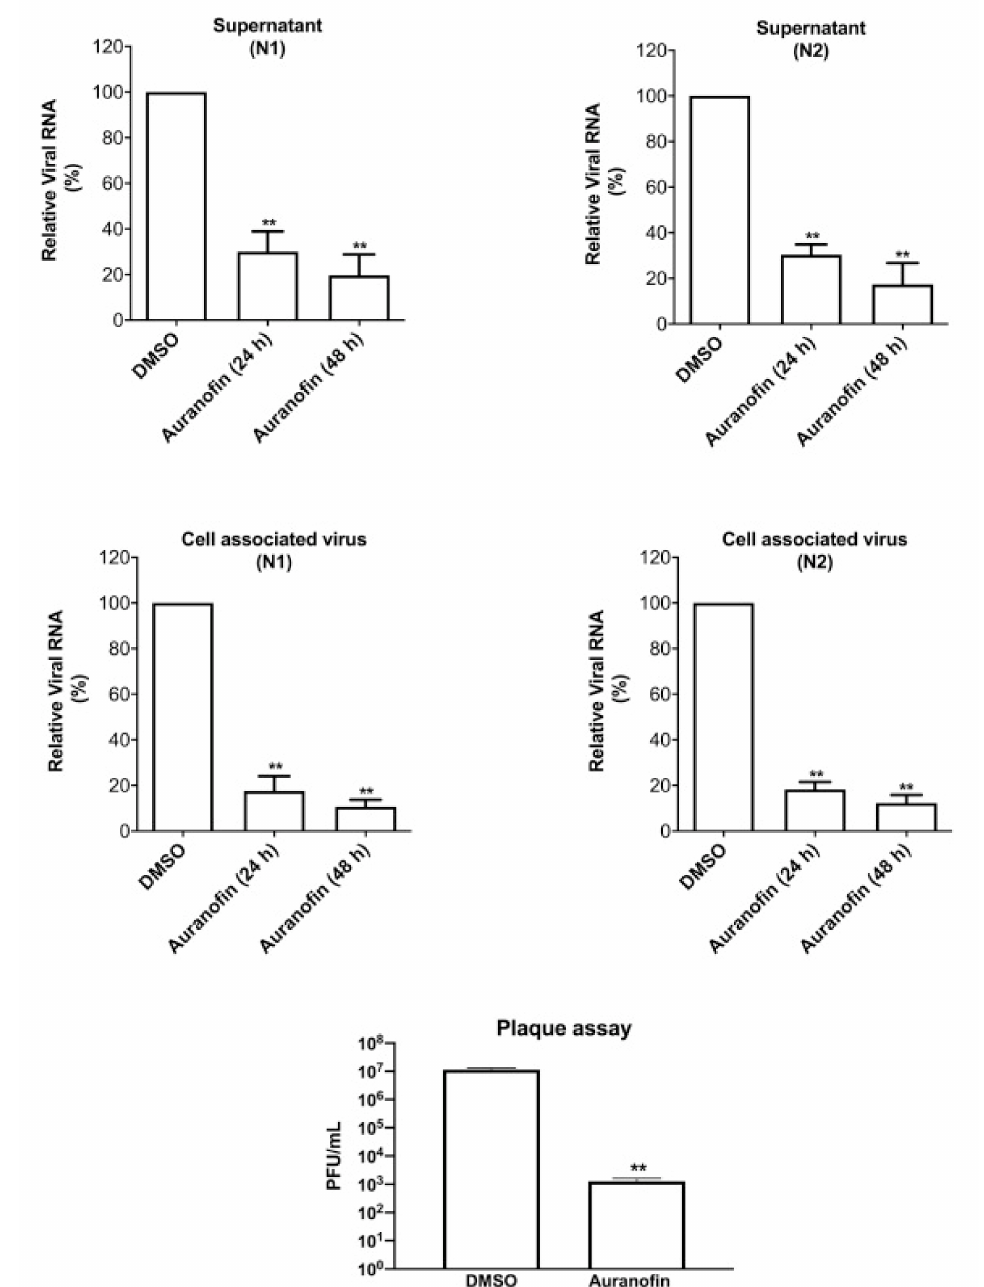
Figure 7. Auranofin inhibits SARS-CoV-2 proliferation in living organisms. Huh7 infection is associated with SARS-CoV-2 for 2 h at a multitude of infected (MOI) from one before ever being incubated with 4 M auranofin or 0.1 DMSO. Cell lysates and culturing filtrates were obtained 24 and 48 h after transmission, and viral RNA rates were measured using RT-PCR using primers and probe targeting the SARS-CoV-2 N1 and SARS-CoV-2 N2 regions. After measuring, standardizing, and correcting the human RNA extracted form tumor cells, the viral RNA values per ug of total cellular RNA were determined. The outcomes were compared for all specific primers, revealing a significant drop in viral RNA following 24 and 48 h. SARS-CoV-2 transmissibility titers were obtained using a cell test.48 h after invasion, in culturing filtrates The data are the mean SEM of two separate tests performed in duplicate, t -test ** p < 0.001. Reprinted/adapted with permission from Ref.